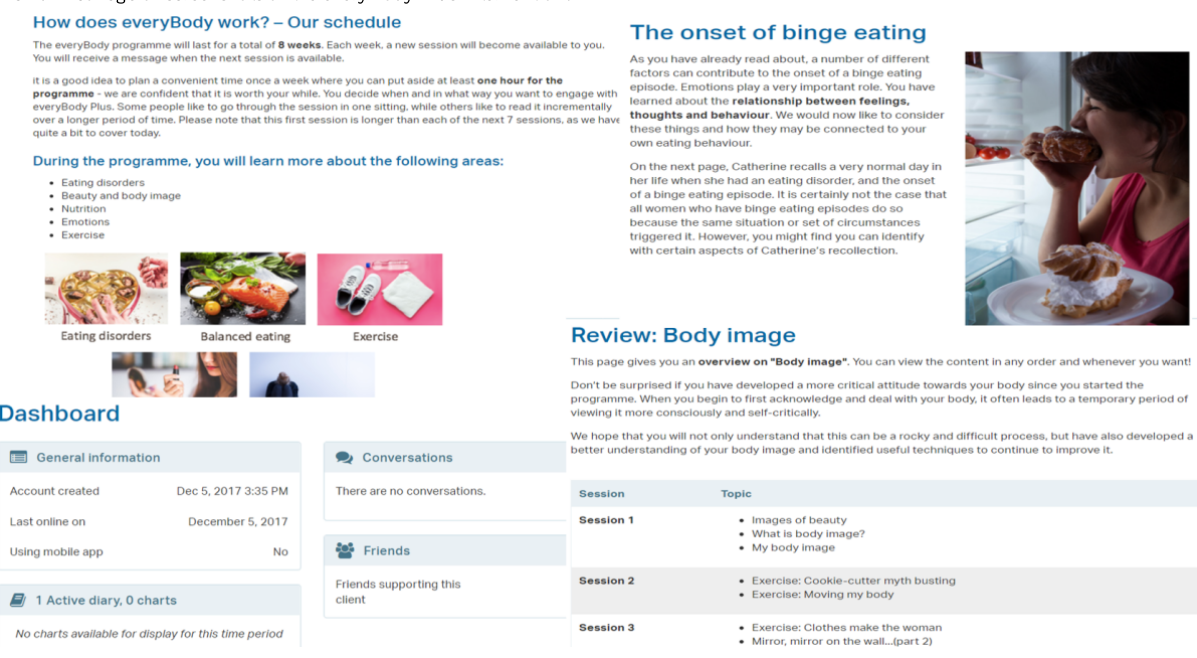
Figure 1. A collage of screenshots of the everyBody Plus